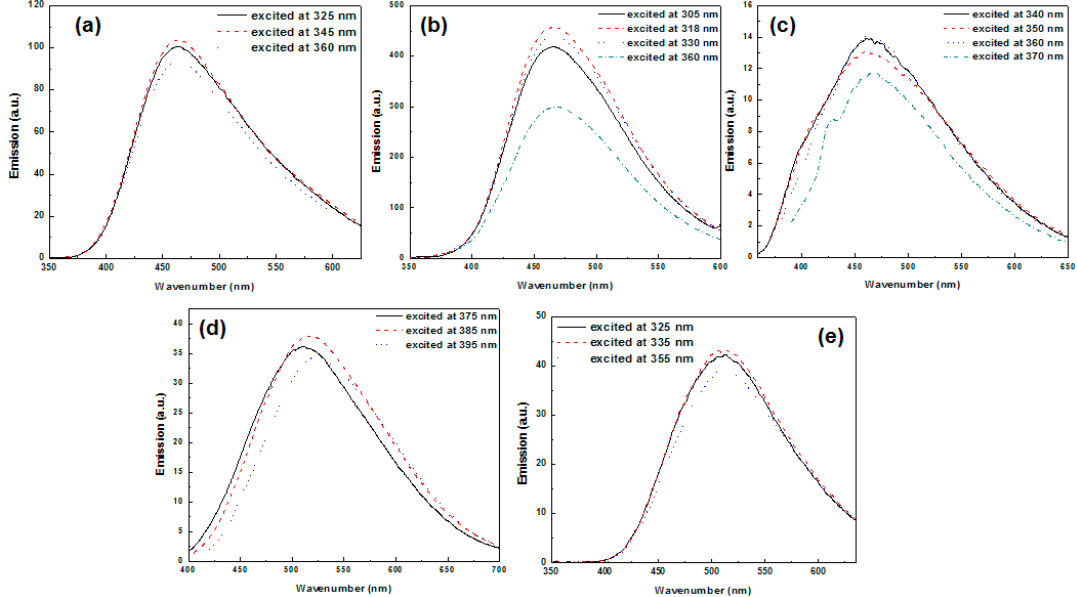
Figure 9. Emission spectra of polymers ( a ) II-1 , ( b ) II-2 , ( c ) II-3 , ( d ) II-4 and ( e ) II-5 in thin films cast from methanol at various excitation wavelengths.